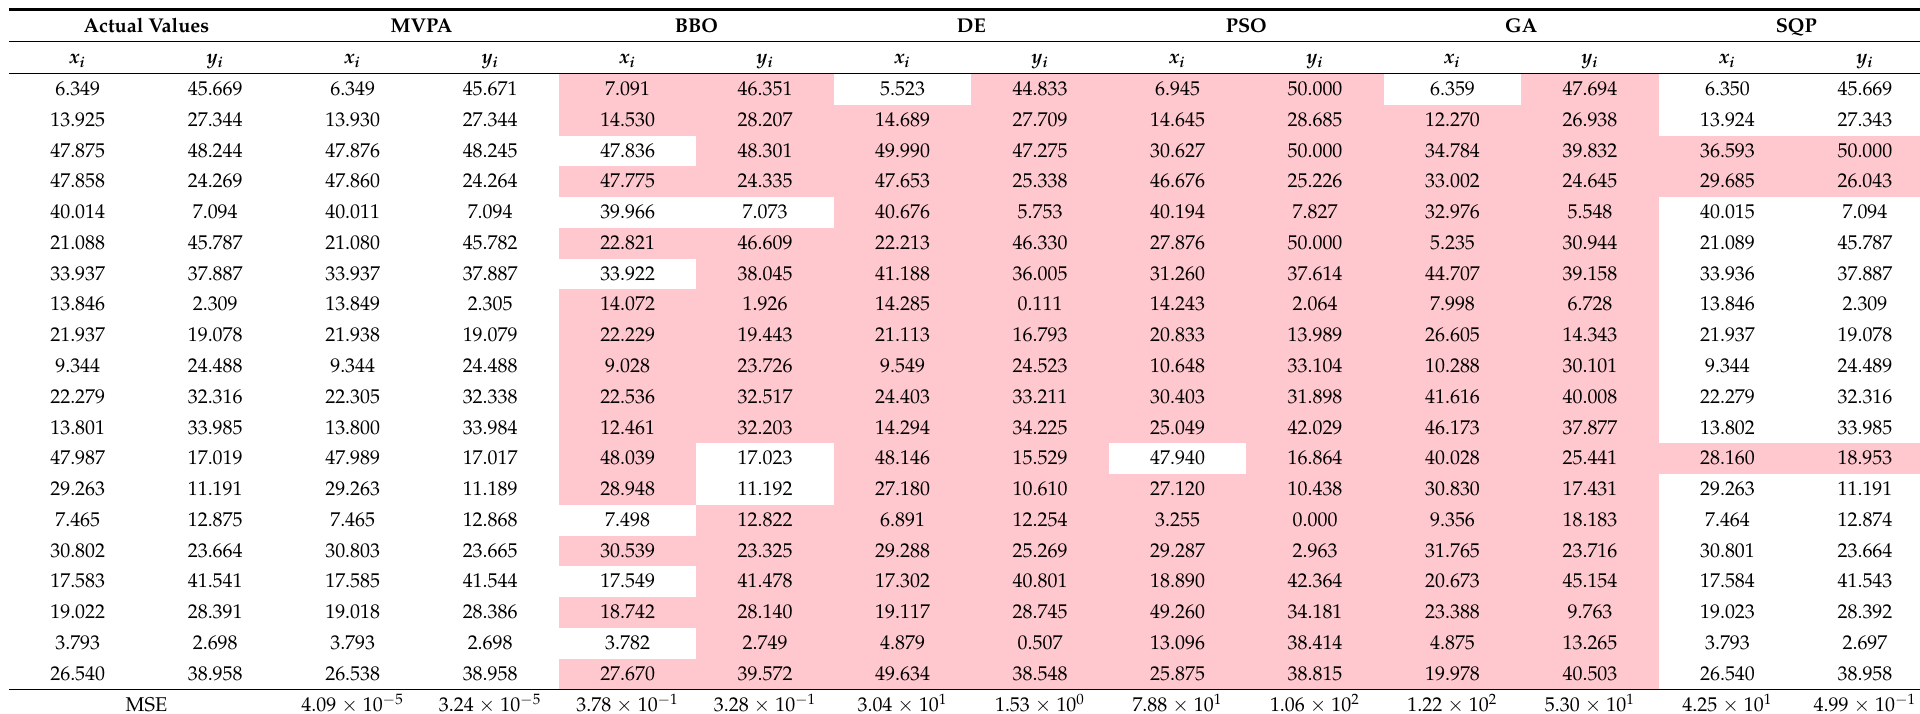
Table 2. Comparison of actual locations with those obtained using different algorithms for case